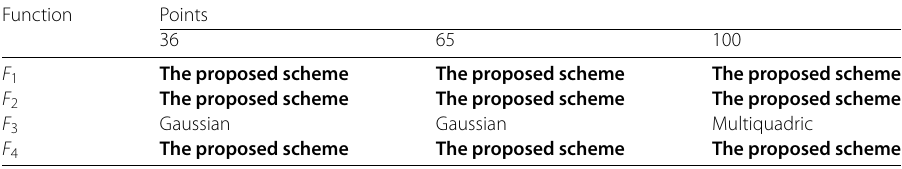
Table 4 The best scheme according to error analysis